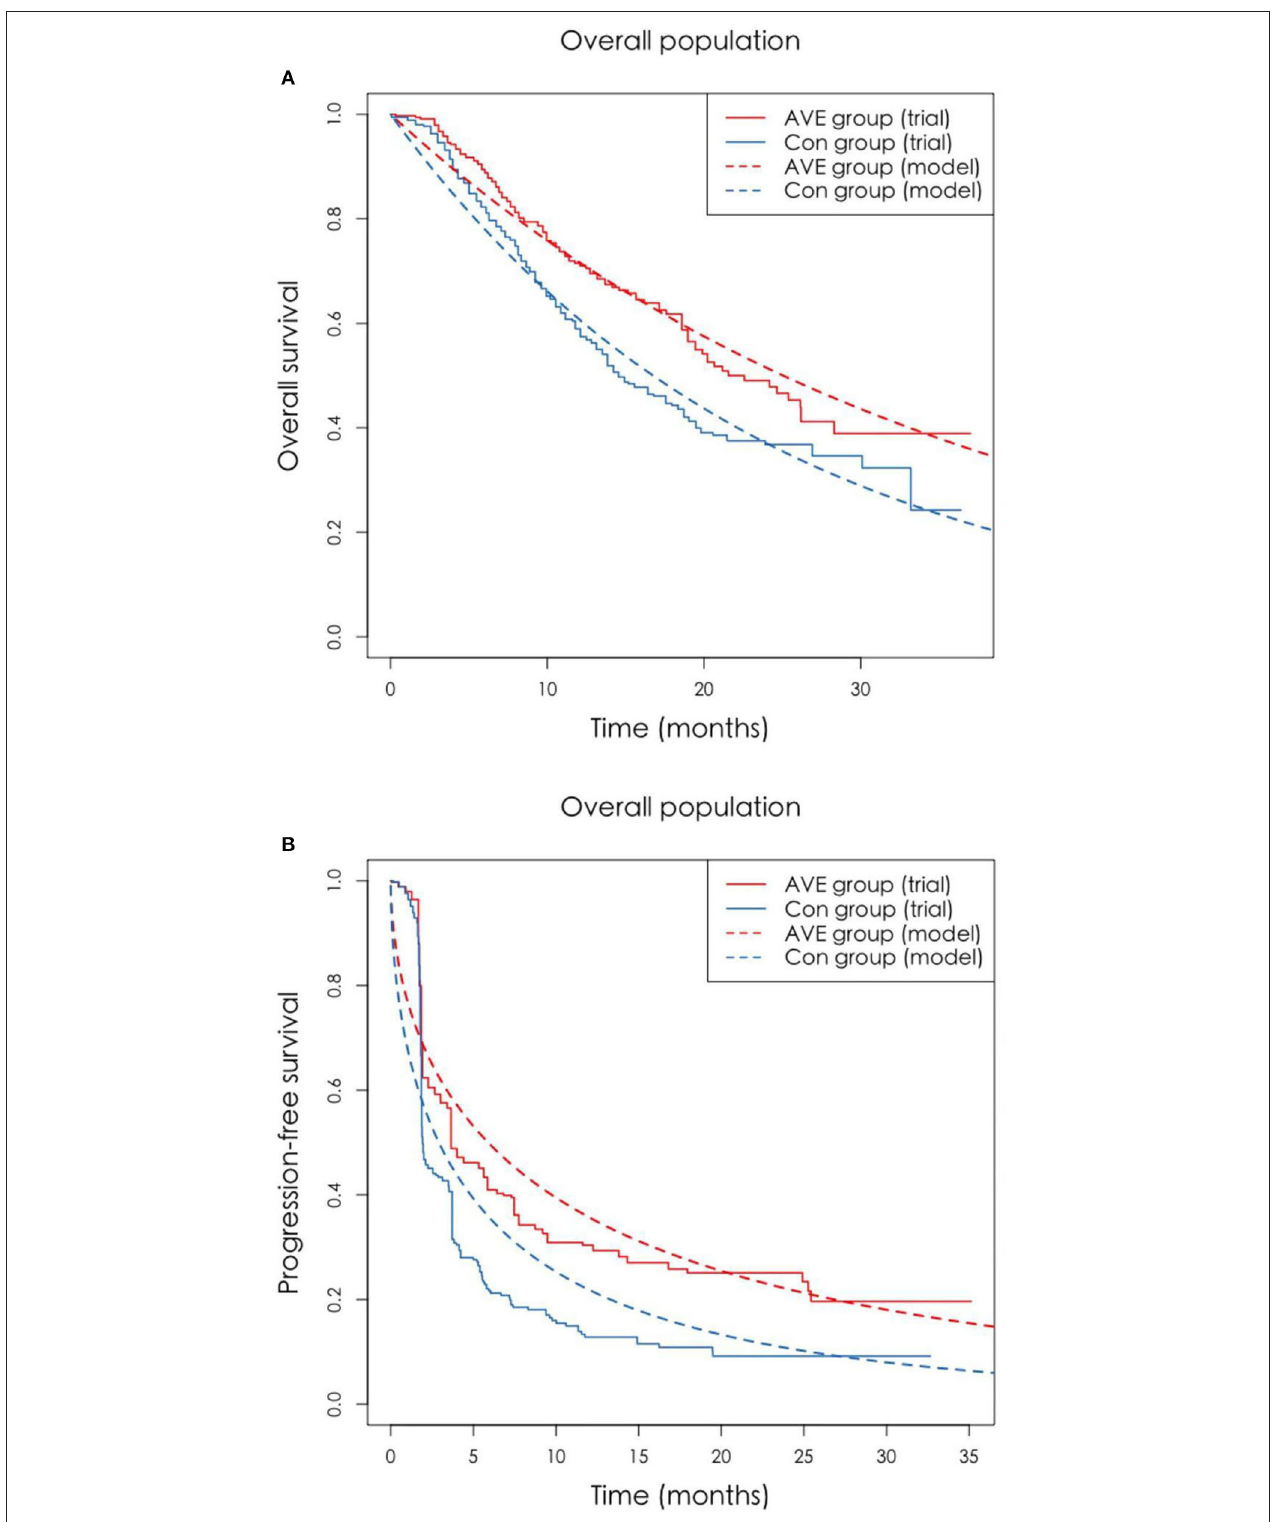
FIGURE 2 | (A,B) The original Kaplan-Meier PFS and OS curves from the trial and fitted curves (Weibull distributions). OS, overall survival; PFS, progression-free survival.